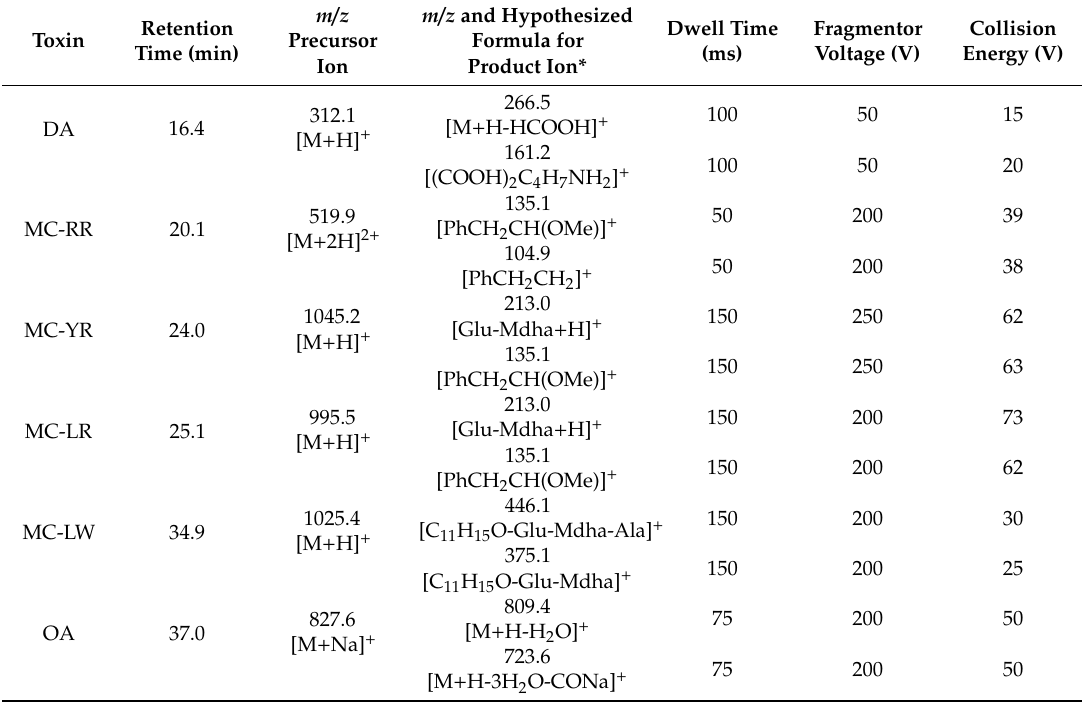
Table 2. Instrumental